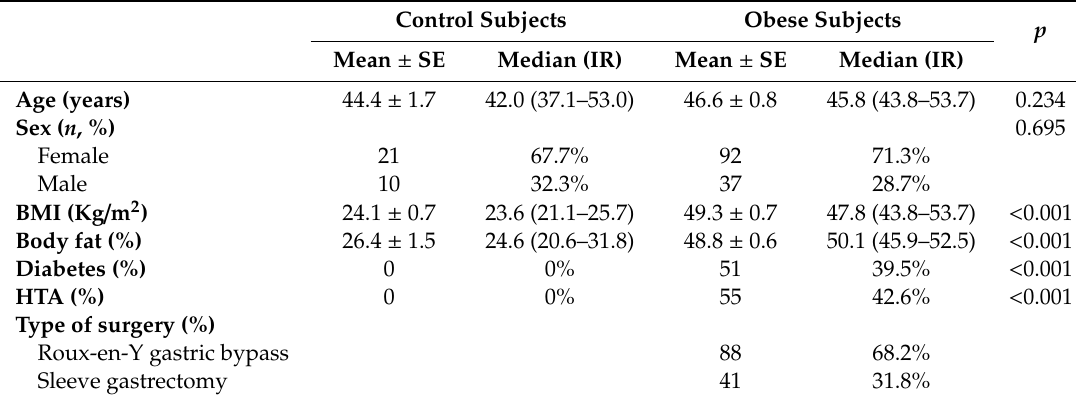
Table 1. Preoperative characteristics of the control subjects and the obese patients (mean ± SE; median, interquartile ranges).